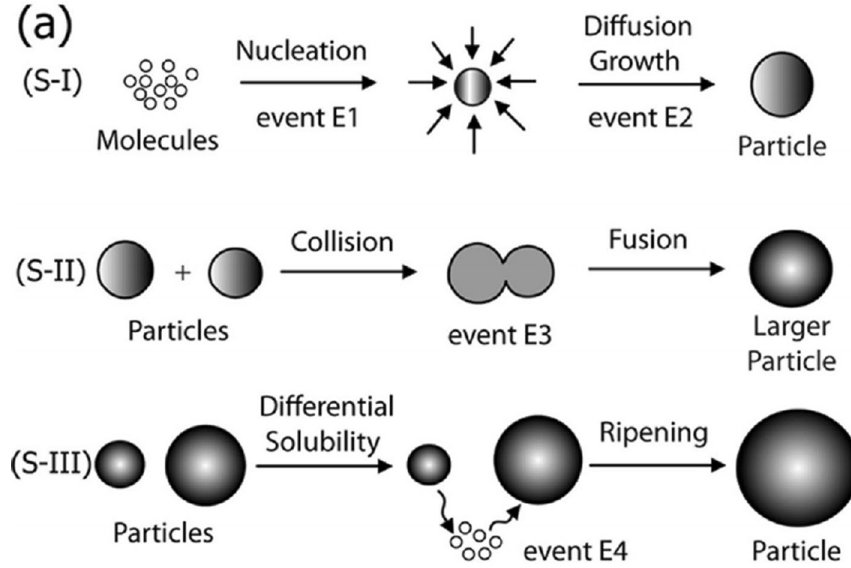
Fig. 2 Schematic of the stage wise-growth of ZnO nanocrys- tals in solution created based on the research by Layek et al.